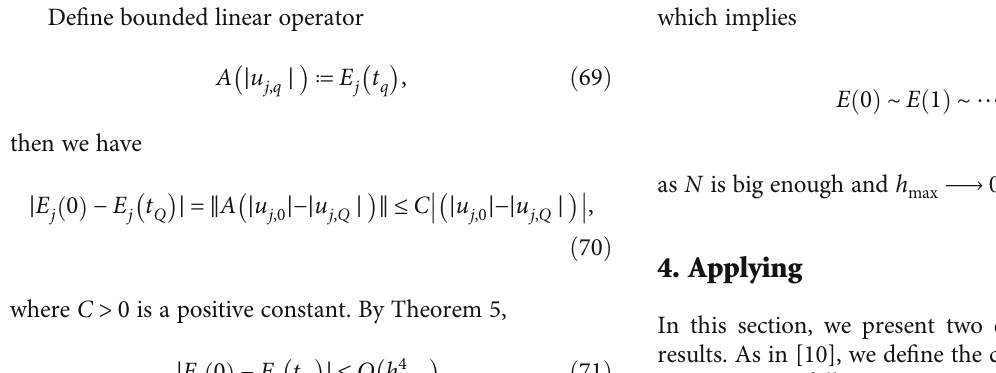
Figure 5: The approximate solution on the region ½ 0, 60 (cid:2) × ½ − π , π (cid:2) for Example